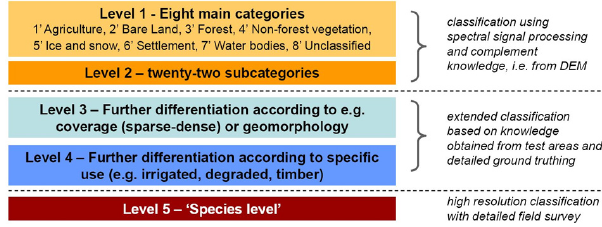
Figure 5. Overview of the BRAHMATWINN land use / land cover (LULC) classification